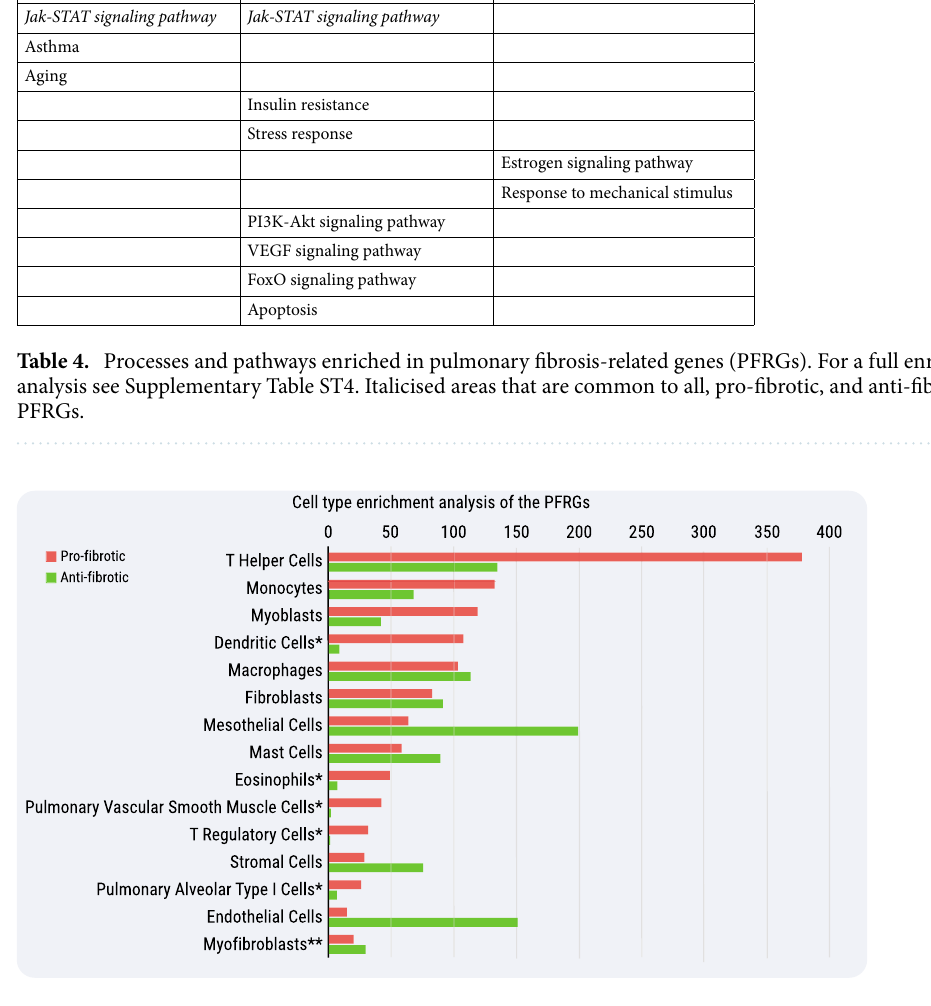
Figure 2. Cell type enrichment analysis of the PFRGs. Pro- and anti-fibrotic genes were tested for expression enrichment in specific cell types. Analysis was performed against the PanglaoDB database on the Enrichr platform. Presented are the main enriched cell types for both lists and their combined enrichment score (see methods) for pro-fibrotic (red) and anti-fibrotic (green). *Non-significant enrichment in anti-fibrotic genes ( p > 0.05) and **Non-significant enrichment in pro-fibrotic genes ( p >